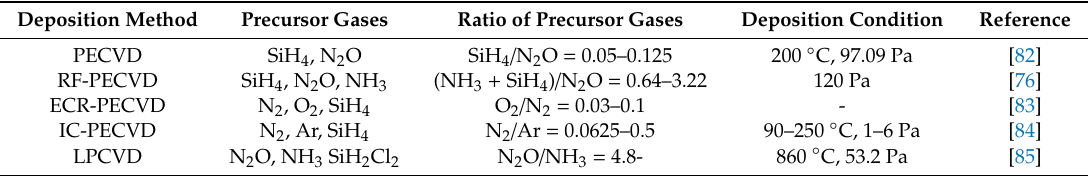
Table 1. Comparison of materials, ratios, and deposition conditions in di ff erent chemical vapor deposition (CVD)